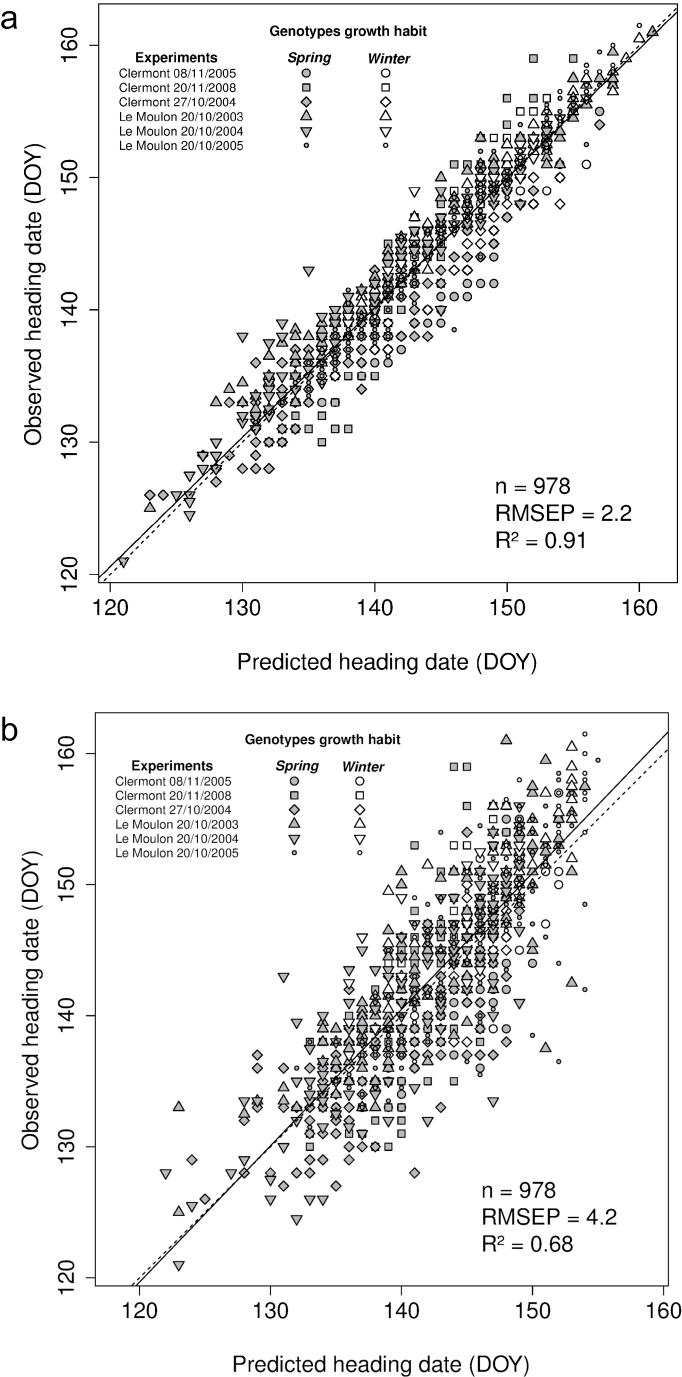
Relationships between observed heading dates and heading dates predicted with two optimized (a) or two QTL-based (b) parameters (2p strategy) for the calibration data set across the autumn-sown experiments using a modified version of the Weir et al. (1984) phenological model. Symbols are filled in white and grey for winter and spring genotypes, respectively. Linear regression (solid) and bisecting (dashed) lines are shown. The number of data points (n), the percentage of variance explained (R2), and RMSEP are indicated.